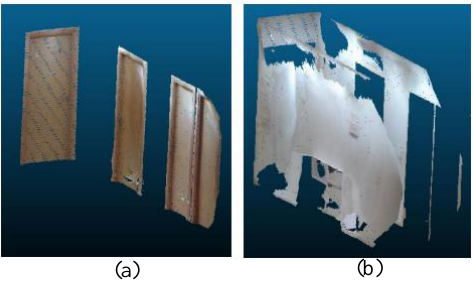
Figure 24. Corridor case: Segmentation of (a) door, (b) wall without openings.